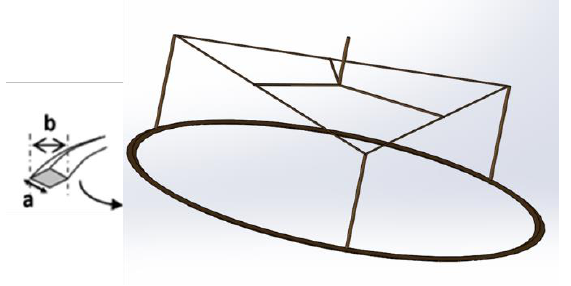
Figure 15. Schematic diagram of the square section of the ring (DWR).